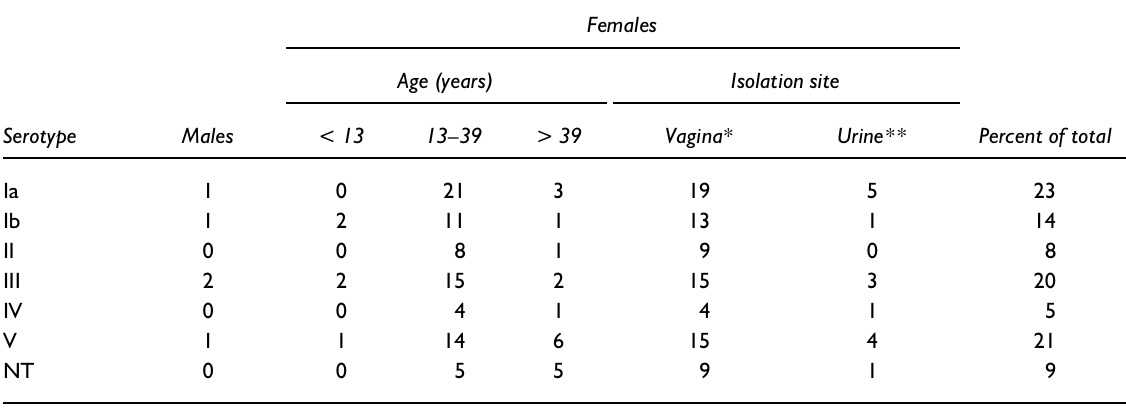
Table 1 GBS serotypes by patients’ sex, age and site of